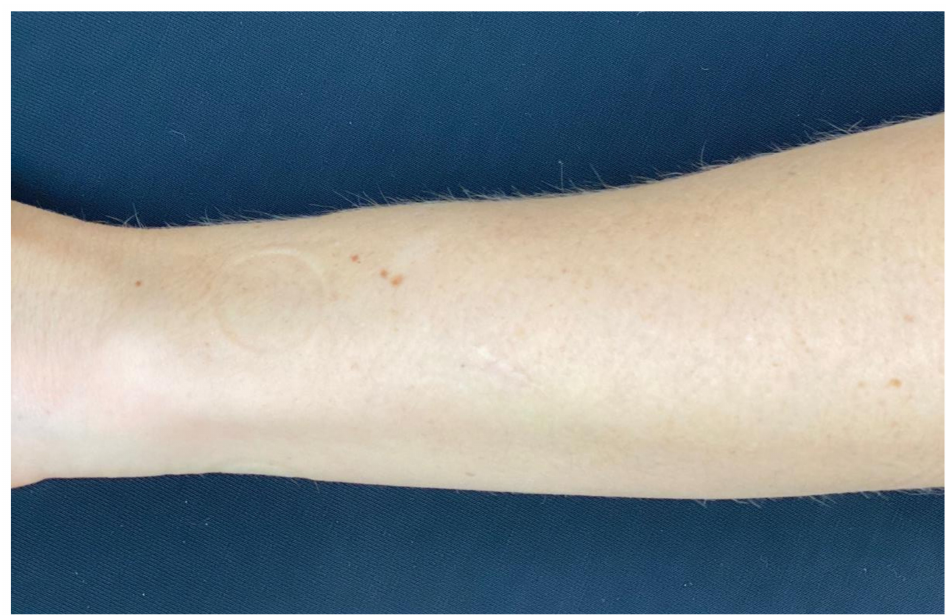
Figure 3. Normotrophic scar after four procedures (after nine months) on the arm.